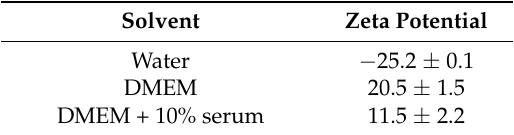
Table 1. Zeta potential of AgNPs in different dispersion